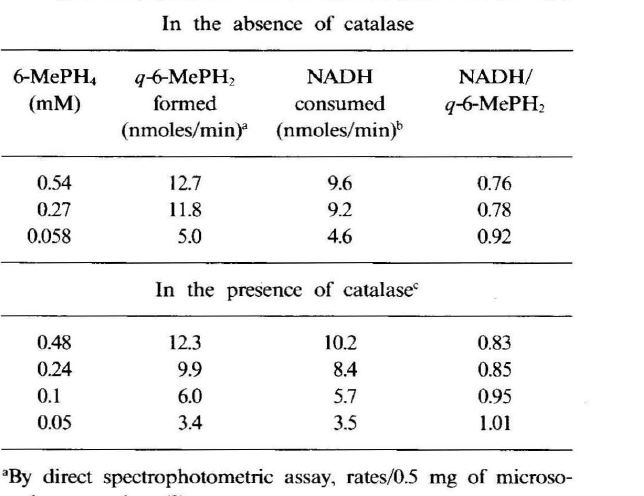
Table 2. Product inhibition of DHPR activity by high concen trations of 6-MePH •. 6-MePH. added Excess 6-MePH. Initial rate of